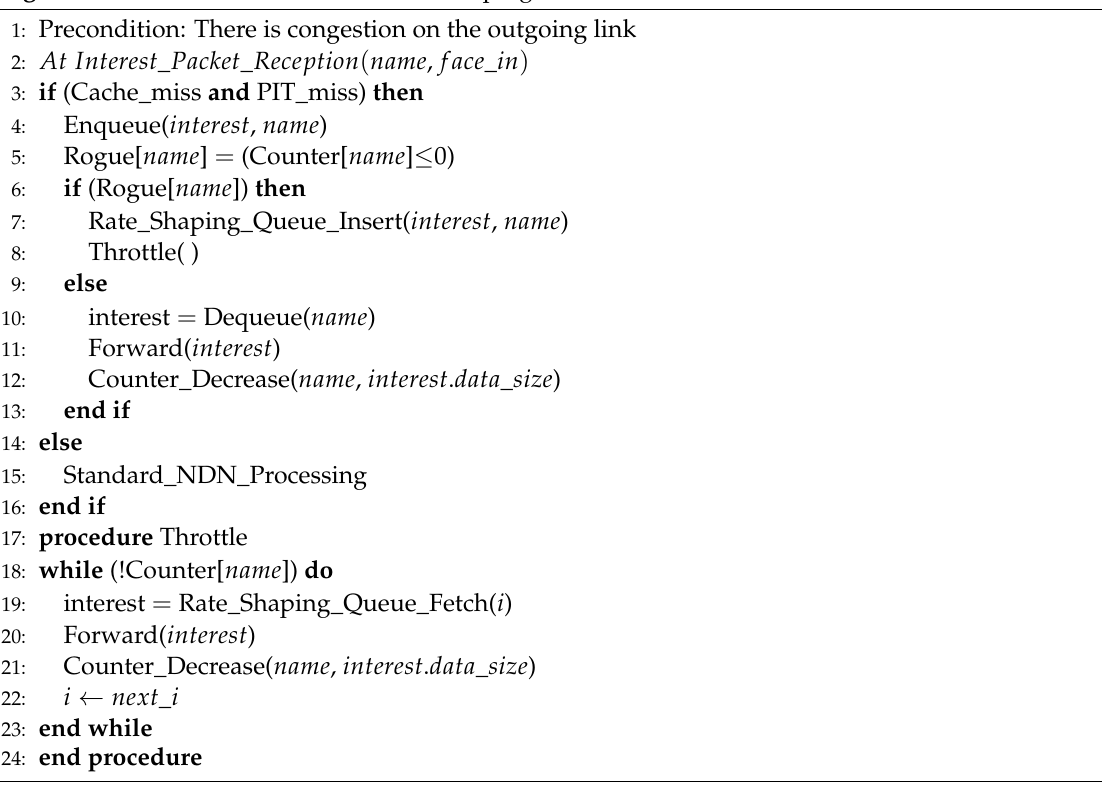
Algorithm 1 Fairness-based interest rate shaping.